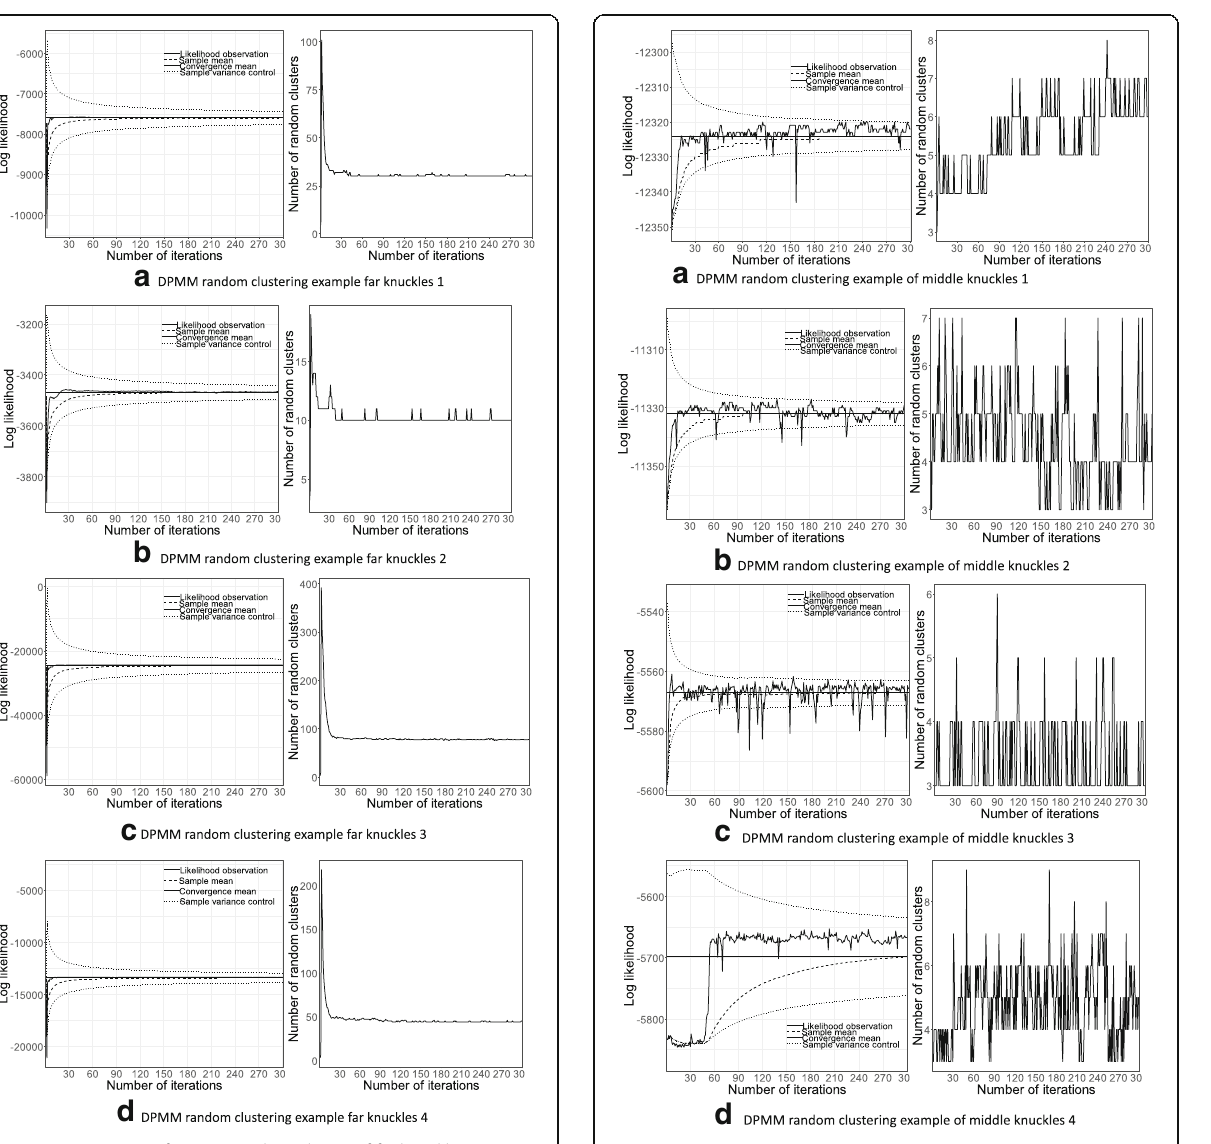
Fig. 5 Convergence of DPMM random cluster of middle knuckles. a DPMM random clustering example of middle knuckles 1. b DPMM random clustering example of middle knuckles 2. c DPMM random clustering example of middle knuckles 3. d DPMM random clustering example of middle knuckles